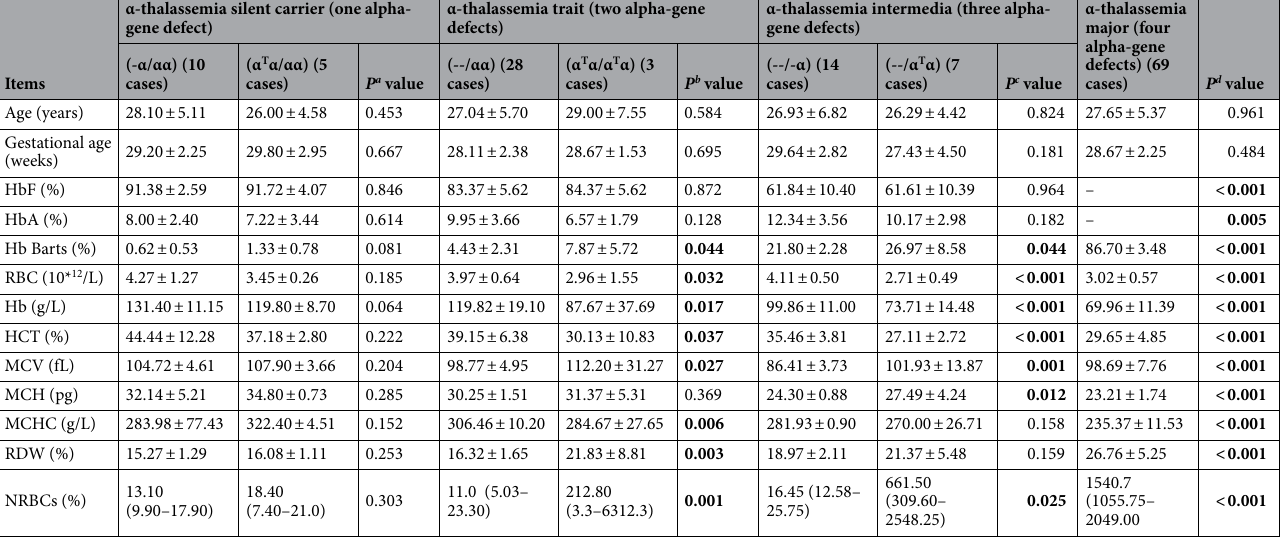
Table 4. Comparison of hematological parameters between fetuses of 4 different α-thalassemia genotypes. P a , P b , P c were the P values of comparison between (-α/αα) and (α T α/αα) group, (--/αα) and (α T α/α T α) group, (--/-α) and (--/α T α) group using Student’s t test for all the hematological parameters except for the NRBCs using Mann–Whitney test, respectively. P d were the P values of comparision among all the α subgroups using Student’s t test for all the hematological parameters except for the NRBCs using Mann–Whitney test. Significant differences ( P < 0.05) are indicated in bold.